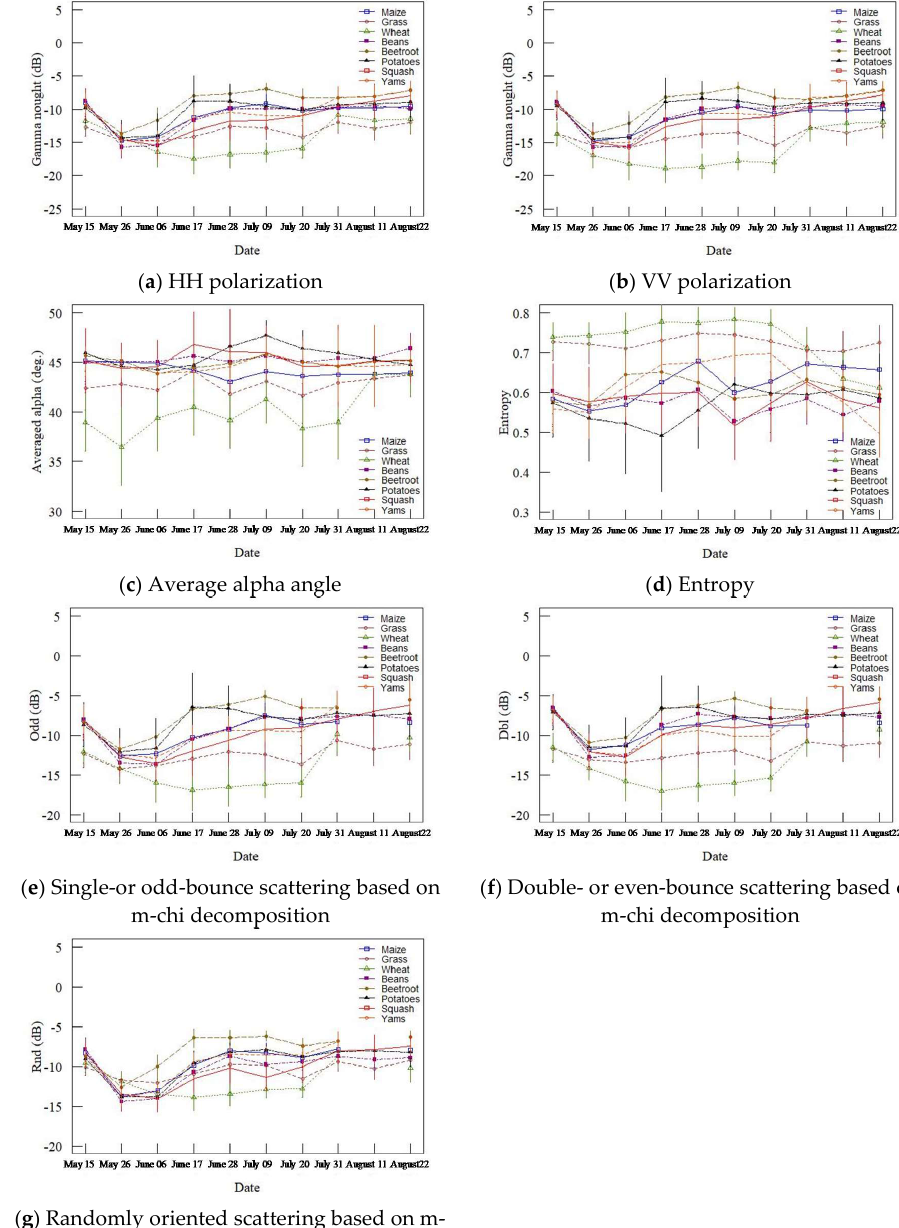
Figure 2. Temporal variation of TerraSAR-X data: gamma naught values of ( a ) HH, ( b ) VV polarization; ( c ) average alpha angle and ( d ) entropy based on the dual polarization entropy/alpha decomposition; ( e ) single- or odd-bounce, ( f ) double- or even-bounce; and ( g ) randomly oriented scattering based on m-chi